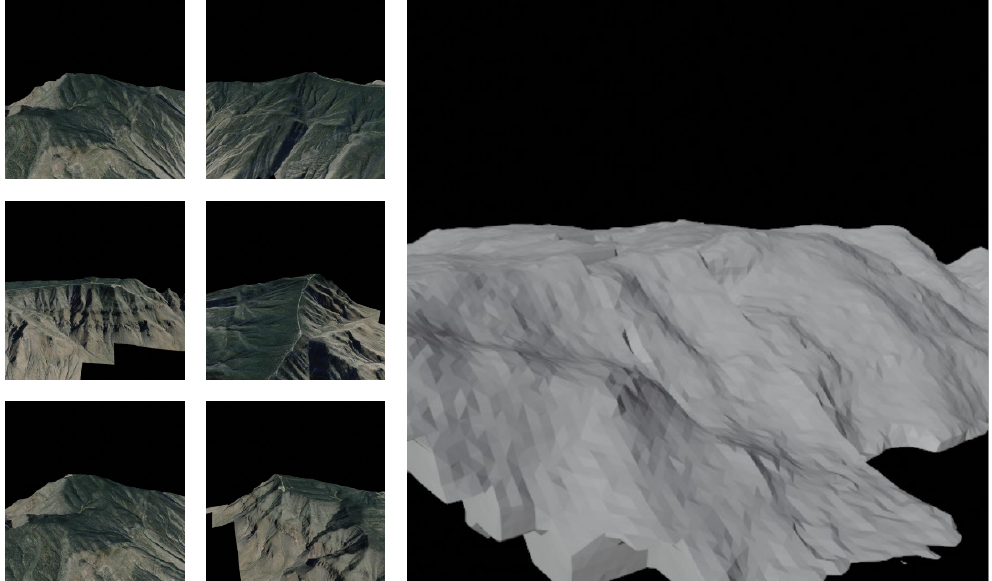
Figure 9. The real data of vegetation-covered mountain terrain. The small images on the left are the six views randomly shot by the camera, and the large image on the right is the reconstruction